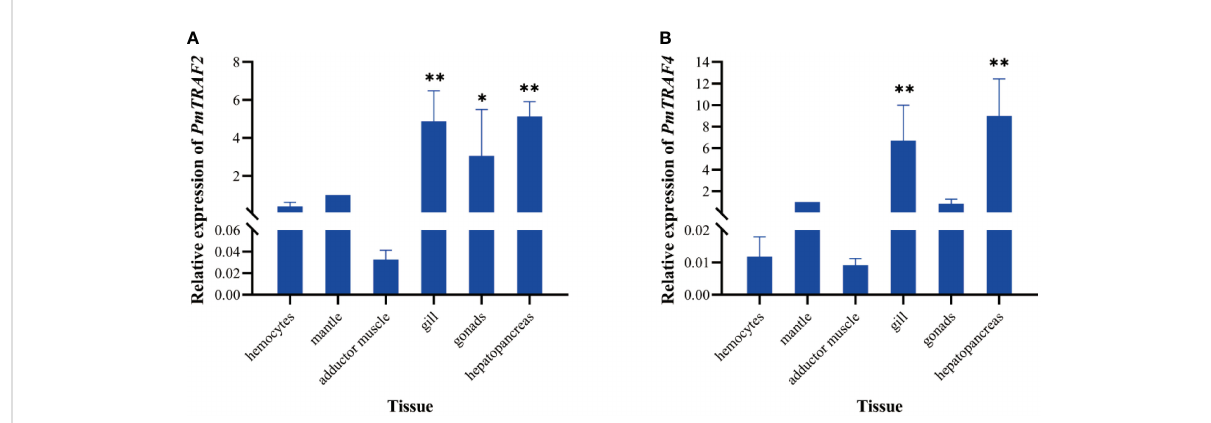
FIGURE 4 Expression distribution of PmTRAF2 (A) and PmTRAF4 (B) in different tissues. Error bars are expressed as the mean ± S.D. (n = 5). Asterisks denote signi fi cant differences: ** p < 0.01; * p <